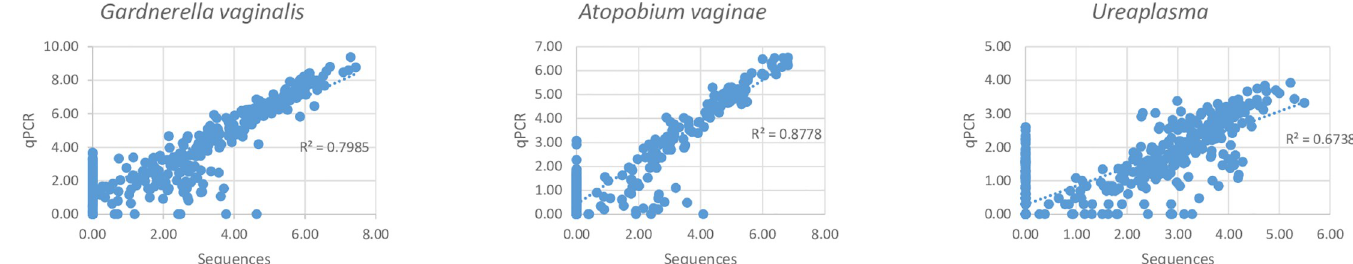
Fig 6. Correlation between sequences and qPCR for G . vaginalis , A . vaginae and Ureaplasma . The bacterial load determined by rarefied sequence number multiplied by total bacterial load (sequences) versus the load determined by specific qPCR for Gardnerella vaginalis , Atopobium vaginae and Ureaplasma . Log scale. Ureaplasma is U . parvum and U . urealyticum